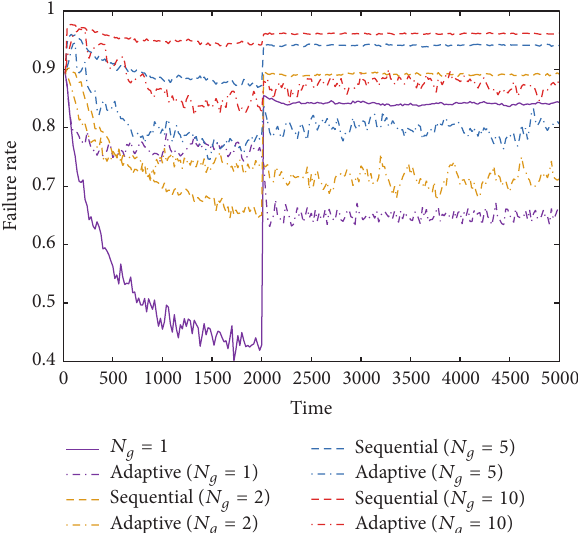
Figure 12: The simulation results of P-EP2P using the sequential topology evaluation method (labeled as “sequential”) and P-EP2P with the adaptive strategy (labeled as “adaptive”) for the evaluation scenario including dynamic environmental change, where each node participates in the network with the probability randomly assigned in between 60% and 100% at every